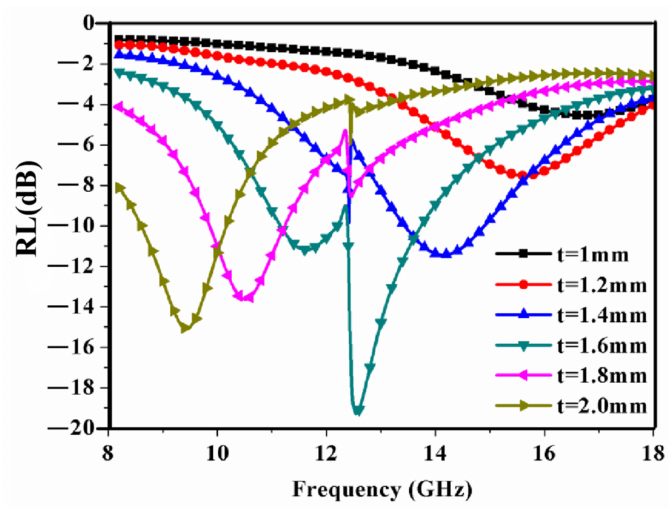
Figure 7. Simulated reflection loss of the RAM versus frequency for different t . C = 10 mm, a = 2